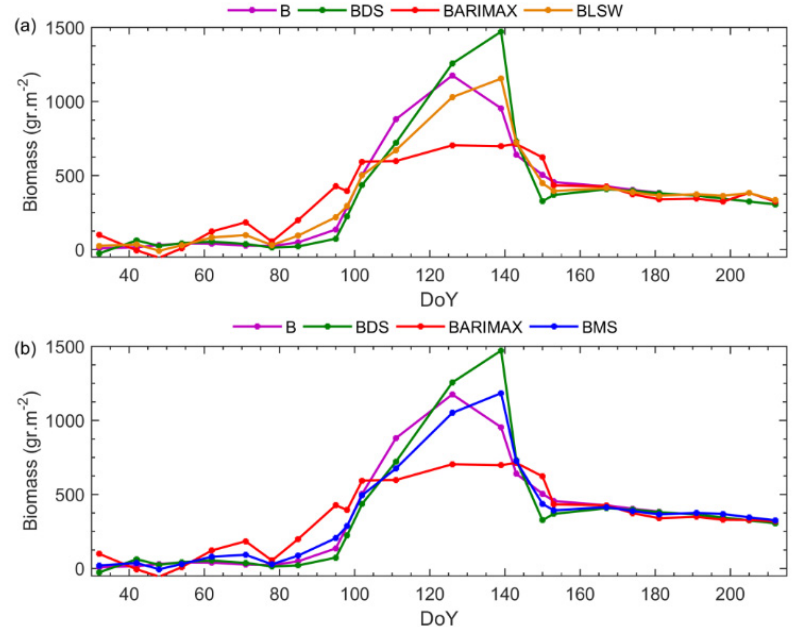
Figure 3. Combination prediction for height: ( a ) weighted least squares; ( b ) mean squared. H: inter- polated data; HDS: double smoothing; HARIMAX: ARIMAX; HLSW: weighted least squares; HMS: mean squared.